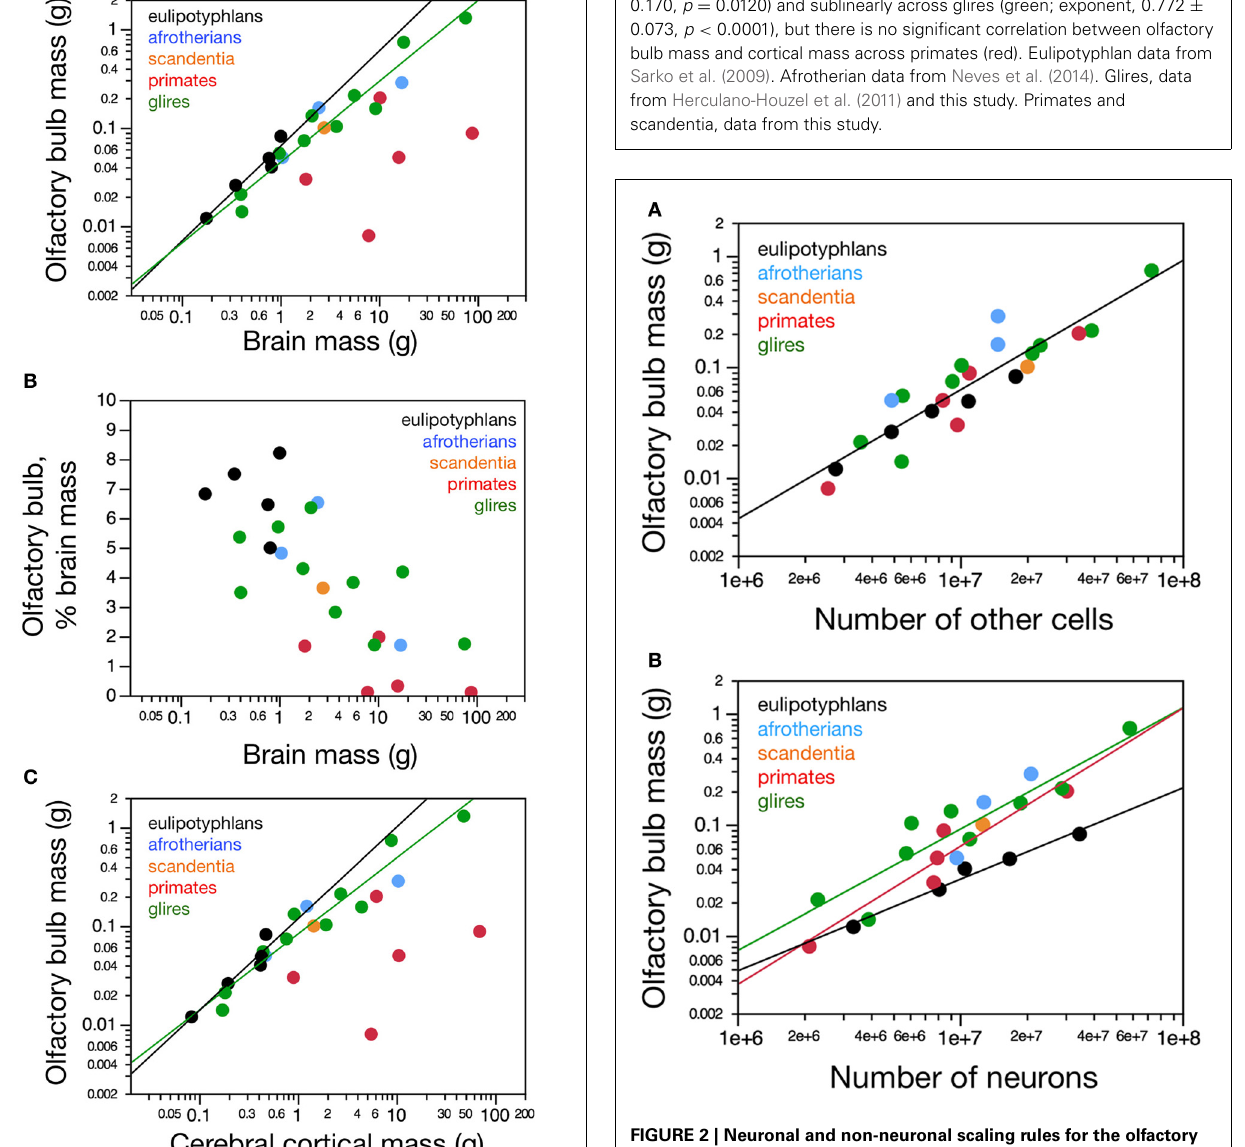
FIGURE 1 | Continued 0.170, p = 0 . 0120) and sublinearly across glires (green; exponent, 0.772 ±